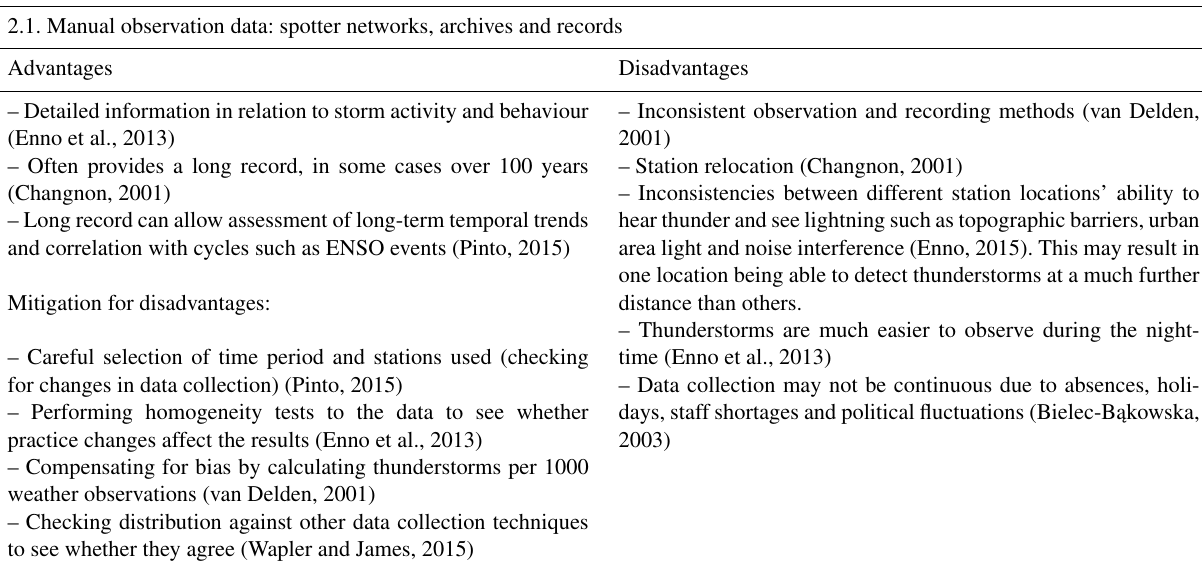
Figure 2. Checklist of questions to consider when choosing the most appropriate dataset. Table 1. Strengths and weaknesses of manual observations used to produce thunderstorm and lightning